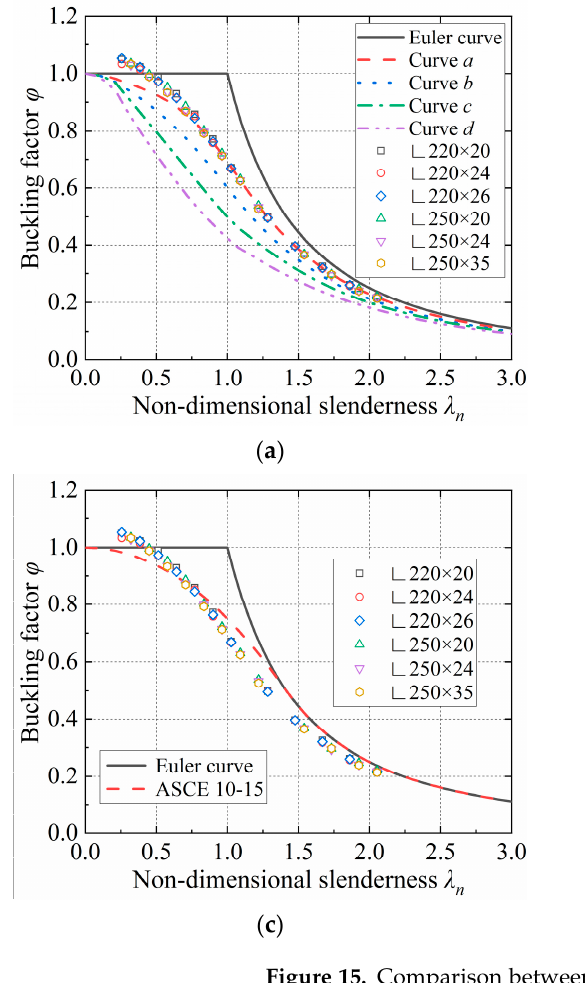
Figure 15. Comparison between Q345 LAS FE results (different section sizes) and design curves: